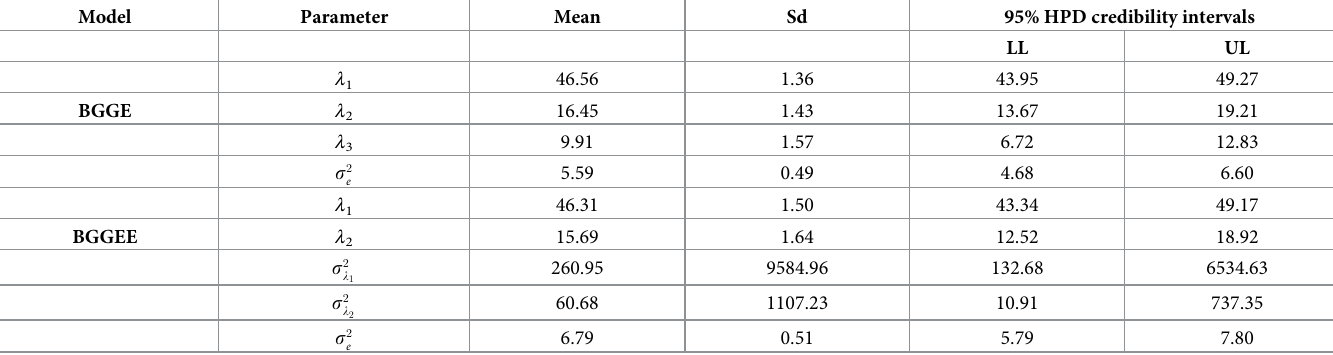
Table 3. Summaries of posterior distributions for singular values and variance components for the BGGE and BGGEE models. Model